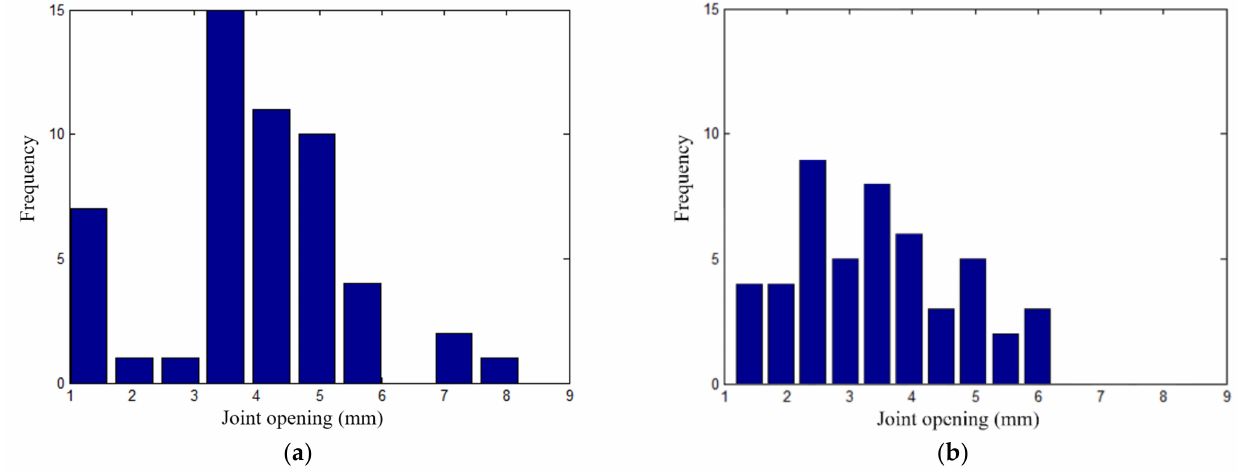
Figure 20. Error frequency distribution of the maximum joint openings in a ring measured at the project. ( a ) Maximum circumferential joint opening; ( b ) maximum longitudinal joint